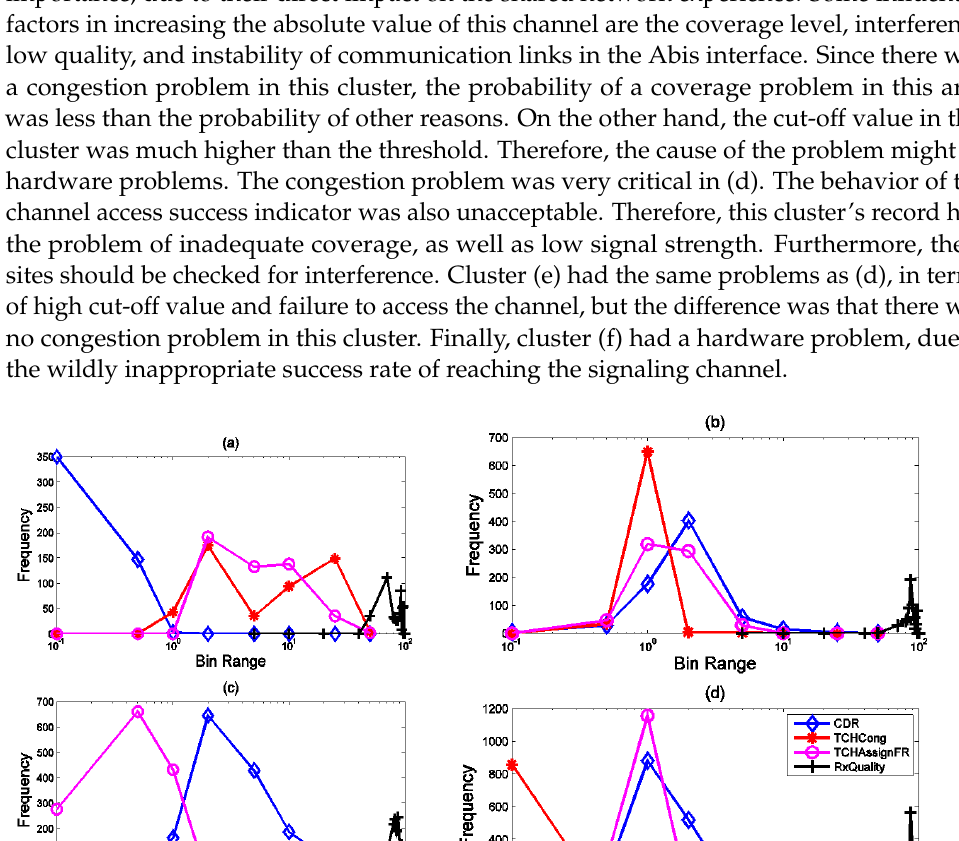
Figure 10. Silhouette coefficient according to the number of clusters for different clustering methods–traffic section.